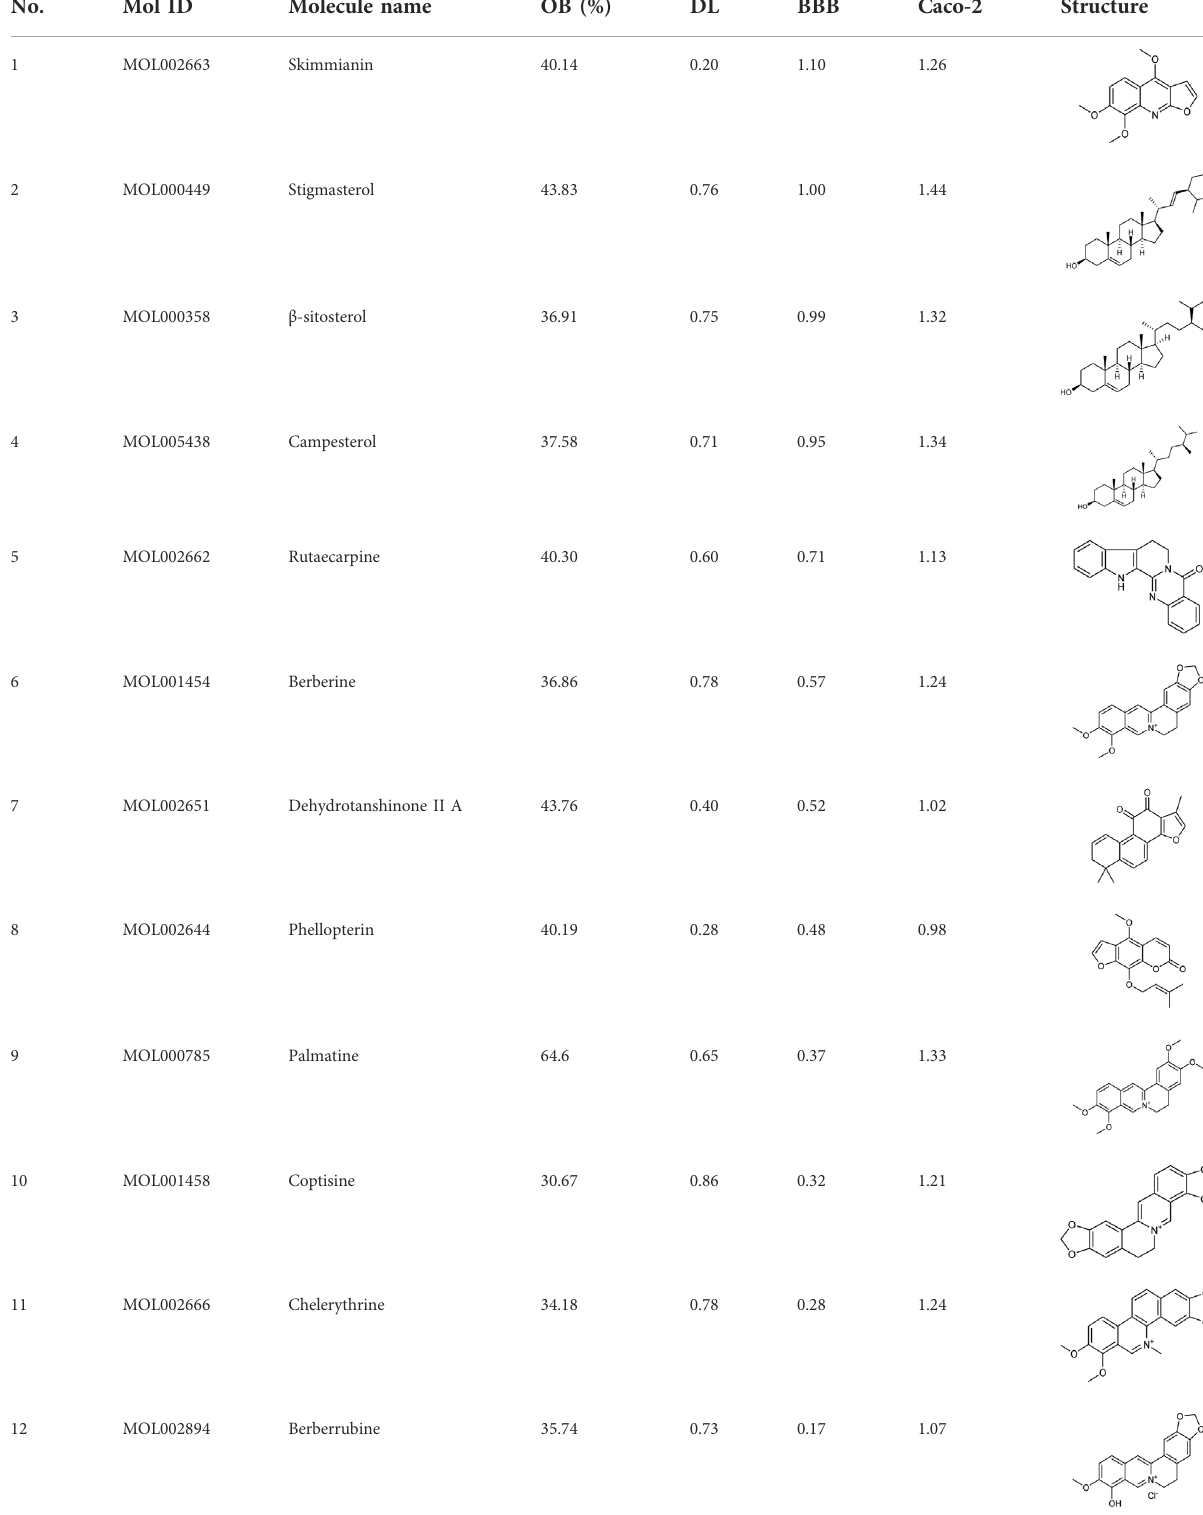
TABLE 2 Information of bioactive compounds of